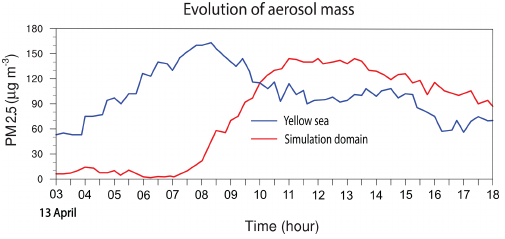
Figure 5. Aerosol size distribution at the surface. N represents aerosol number concentration per unit volume of air and D rep- resents aerosol